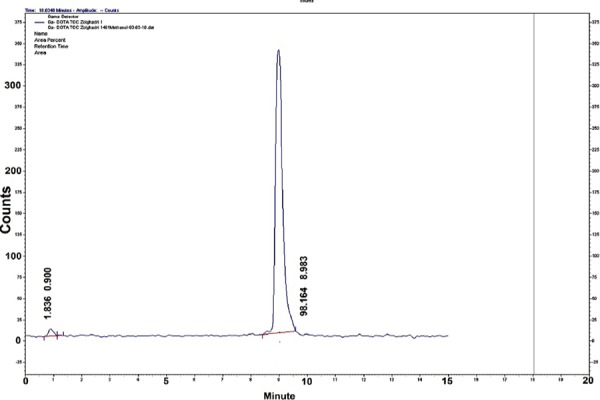
HPLC chromatogram of 68Ga-DOTATOC.